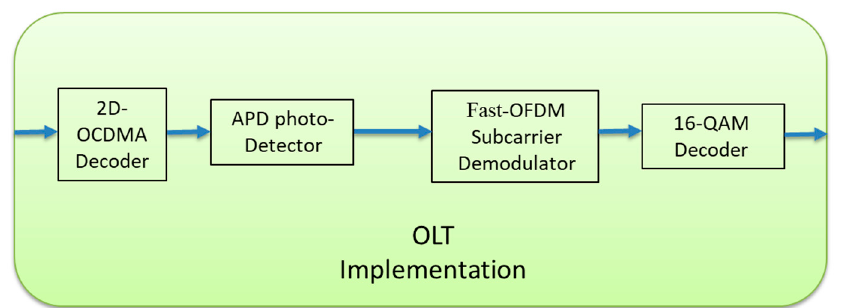
Figure 7. OLT implementation.